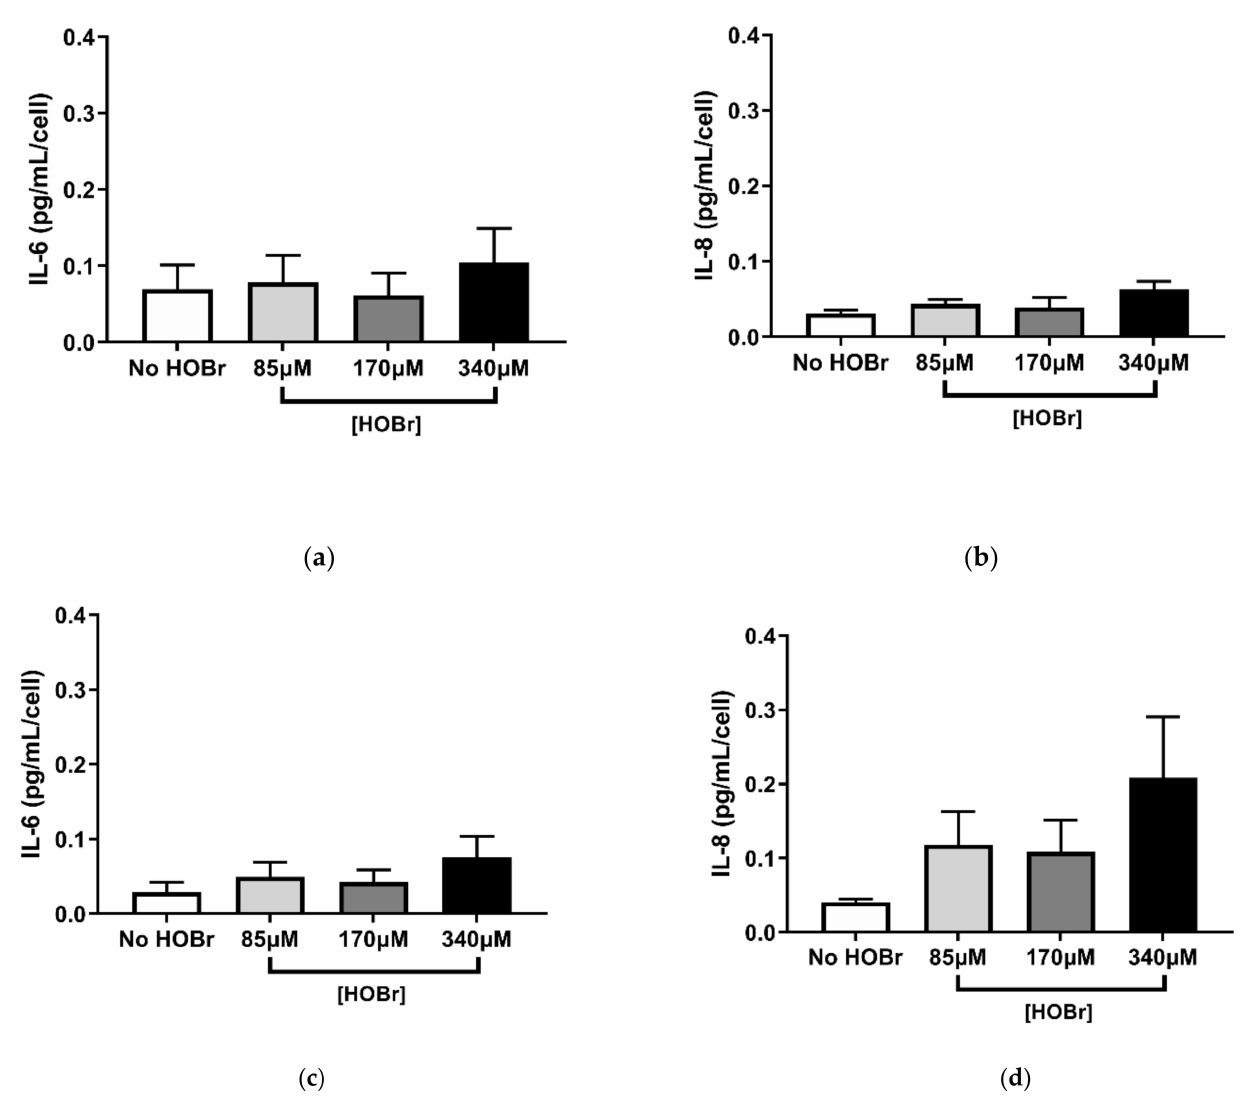
Figure 5. Effects of HOBr-oxidised ECM on fibroblasts’ secretion of inflammatory cytokines. BEAS-2B-derived ECM was oxidised with (or without) HOCl concentrations of 85 µ M, 170 µ M, and 340 µ M for 30 min and seeded with PHLF. Supernatants were collected after 24 h ( a,b ) and 96 h ( c , d ) to measure the concentrations of IL-6 ( a , c ) and IL-8 ( b , d ) by ELISA. Results were picograms per microlitre per cell (normalised against the cell counts at 24 h and 96 h post-seeding) and expressed as mean ± SEM. ( a–d ) n =